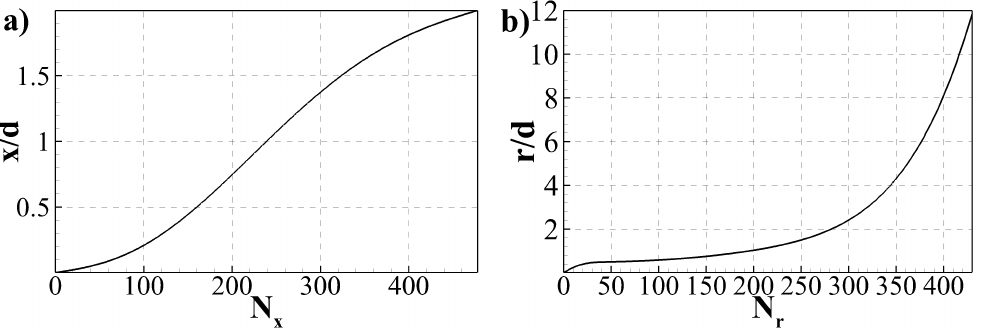
Figure 1. Location of the computational grid points in ( a ) axial and ( b ) radial